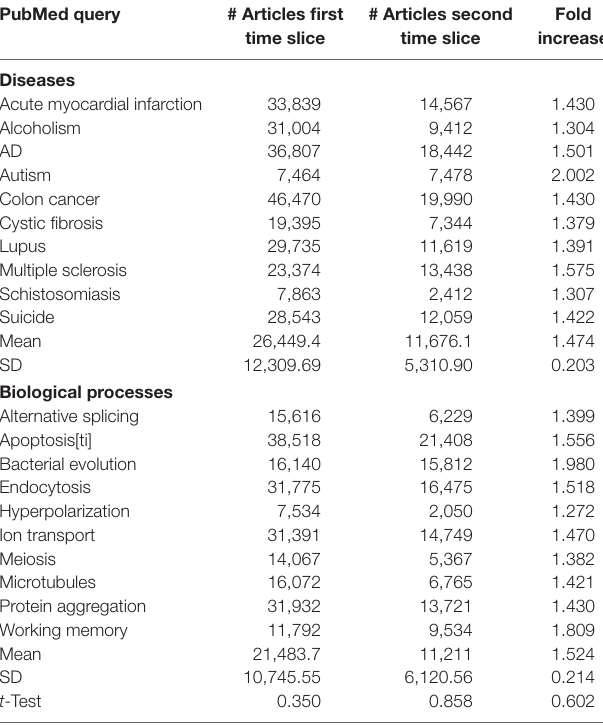
TaBle 1 | article sets obtained by querying PubMed. PubMed